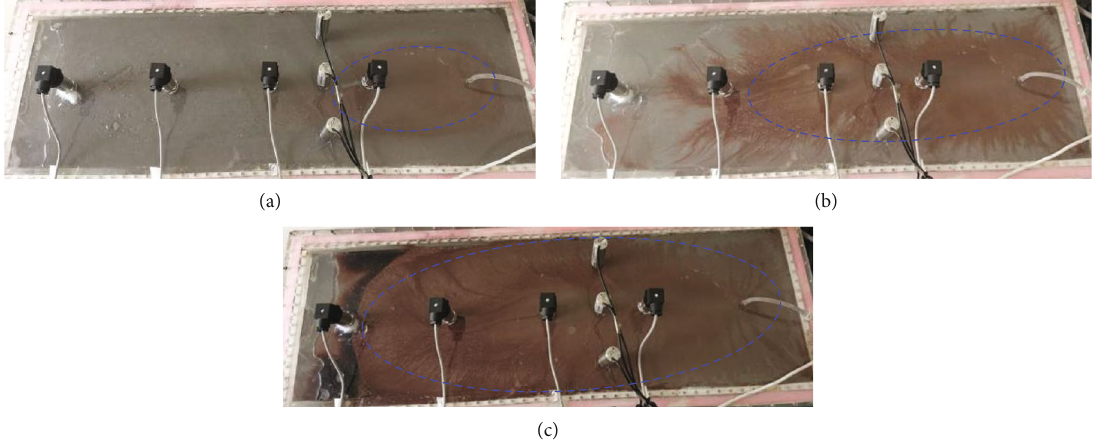
Figure 8: Slurry fl ow channel during pressurized injection. (a) 810s, (b) 1170s, and (c) 1770